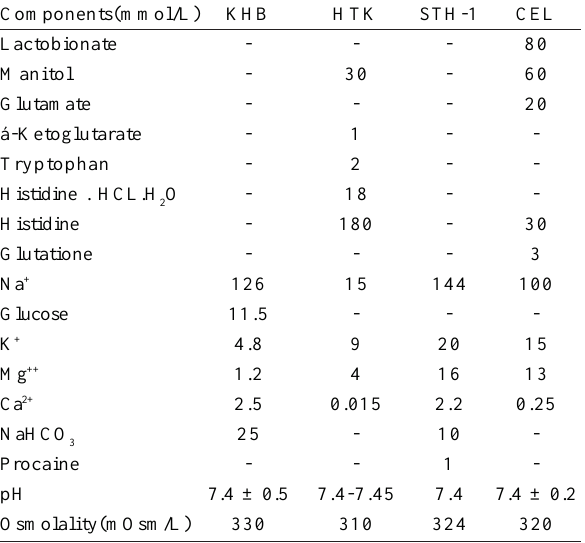
Table 2. Chemical Composition of the solutions studied